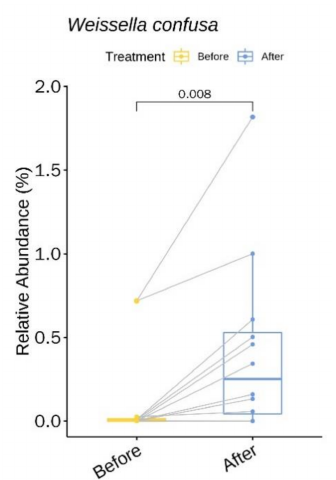
Figure 3. Weissella confusa showing a significantly higher relative abundance upon doxycycline